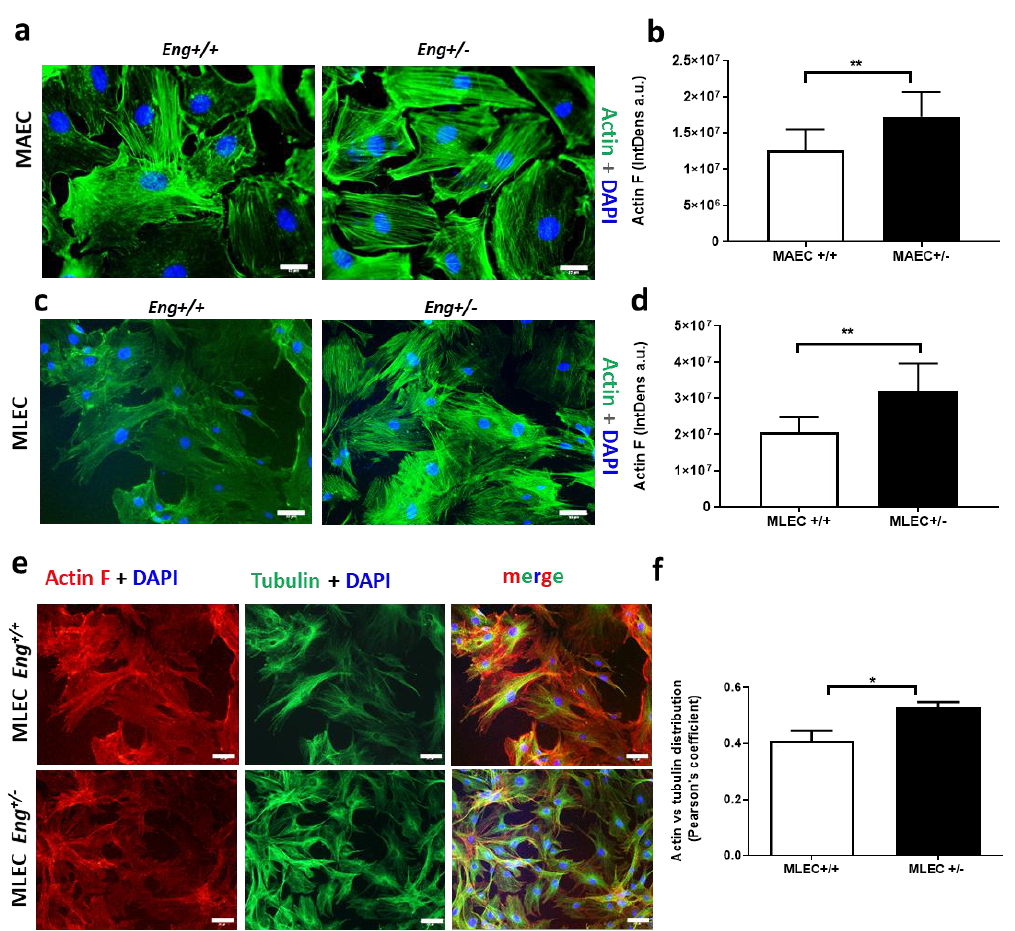
Figure 4. Murine endoglin in MAECs and MLEC is involved in F-actin polymerization and distribution. ( a , b ) Mouse aortic endothelial cells (MAEC) from a model of HHT1, stained for F-actin (green, Alexa 488) and DAPI ( a ), and its quantification ( b ). ( c , d ) Mouse lung endothelial cells (MLEC) from a model of HHT1 stained for F-actin (green, Alexa 488) and DAPI ( c ), and its quantification ( d ). A significant difference (** p < 0.01) between control and Eng +/- conditions was found in terms of actin distribution ( b , d ) by Image J considering fluorescence (IntDens). ( e , f ) Eng +/- MLEC stained for actin and tubulin ( e ) and their co-localization evaluated by Person ’ s coefficient (* p < 0.05) ( f ). (scale bar, 33 µm).